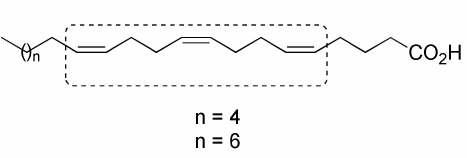
Figure 2. Natural 1Z,5Z,9Z-trienoic acids from the sea anemone S. helianthus